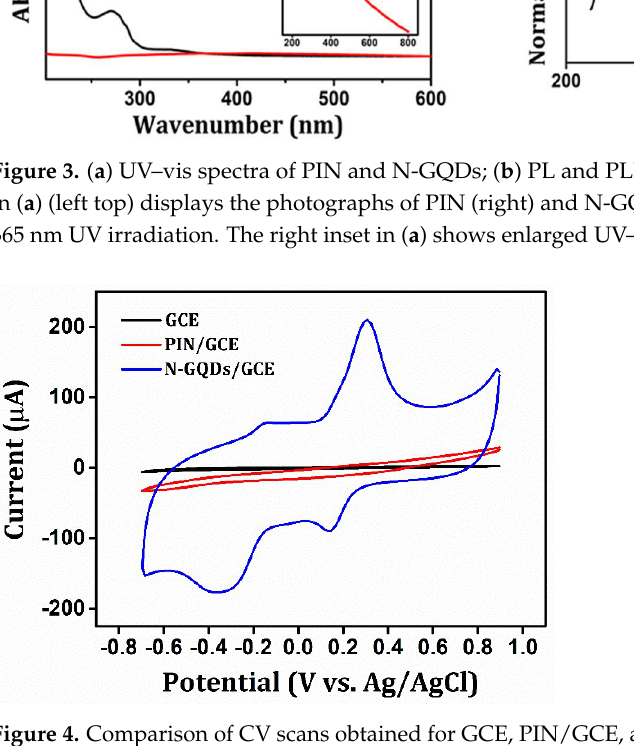
Figure 3. ( a ) UV–vis spectra of PIN and N-GQDs; ( b ) PL and PLE spectrum of N-GQDs. The inset in ( a ) (left top) displays the photographs of PIN (right) and N-GQD (left) under visible light and at 365 nm UV irradiation. The right inset in ( a ) shows enlarged UV–vis spectra of PIN.